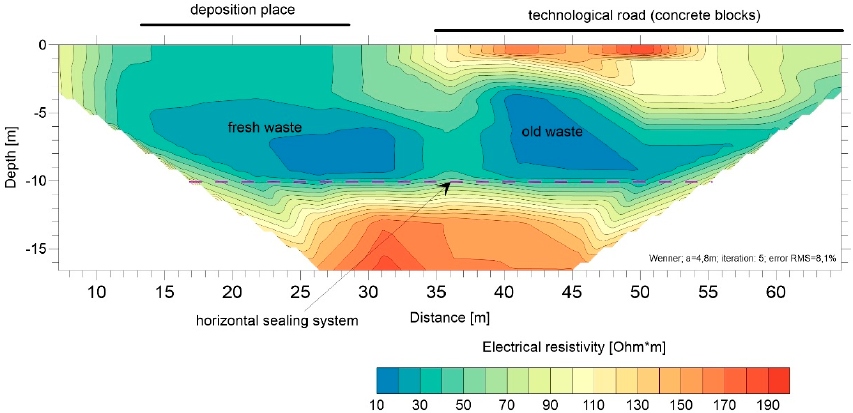
Figure 6. The electrical resistivity cross-section of waste disposal with a bottom sealing system.